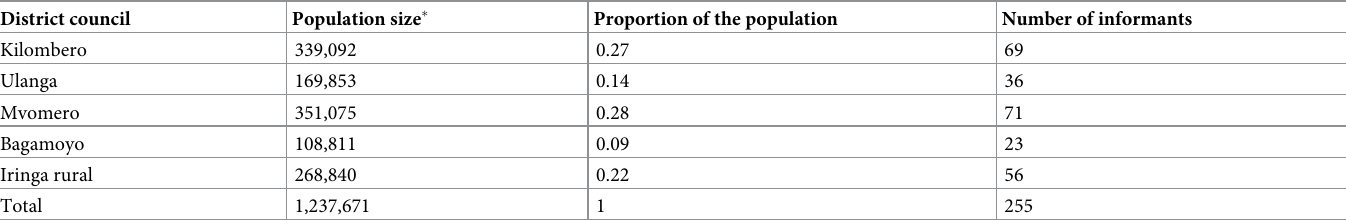
Table 1. Population distribution overview in the study area.